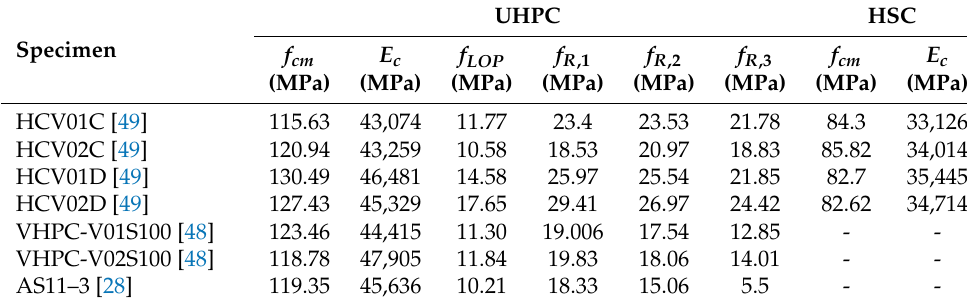
Table 3. Concrete mechanical properties.